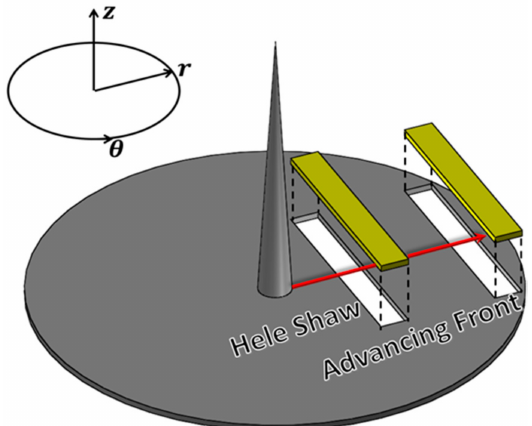
Figure 1. The injection-molded glass/ppcenter-gated disk: The Hele-Shaw region (60% disk radius) and advancing front region (85% disk radius) were investigated in this